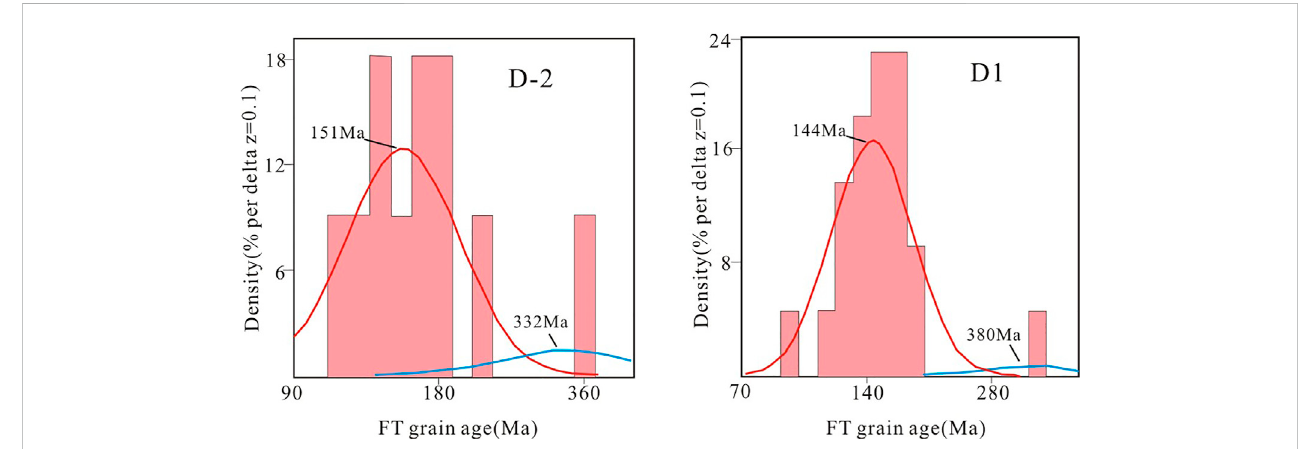
FIGURE 6 Frequency histograms of single grains of ZFT ages and age components calculated by binomial fi tting method.